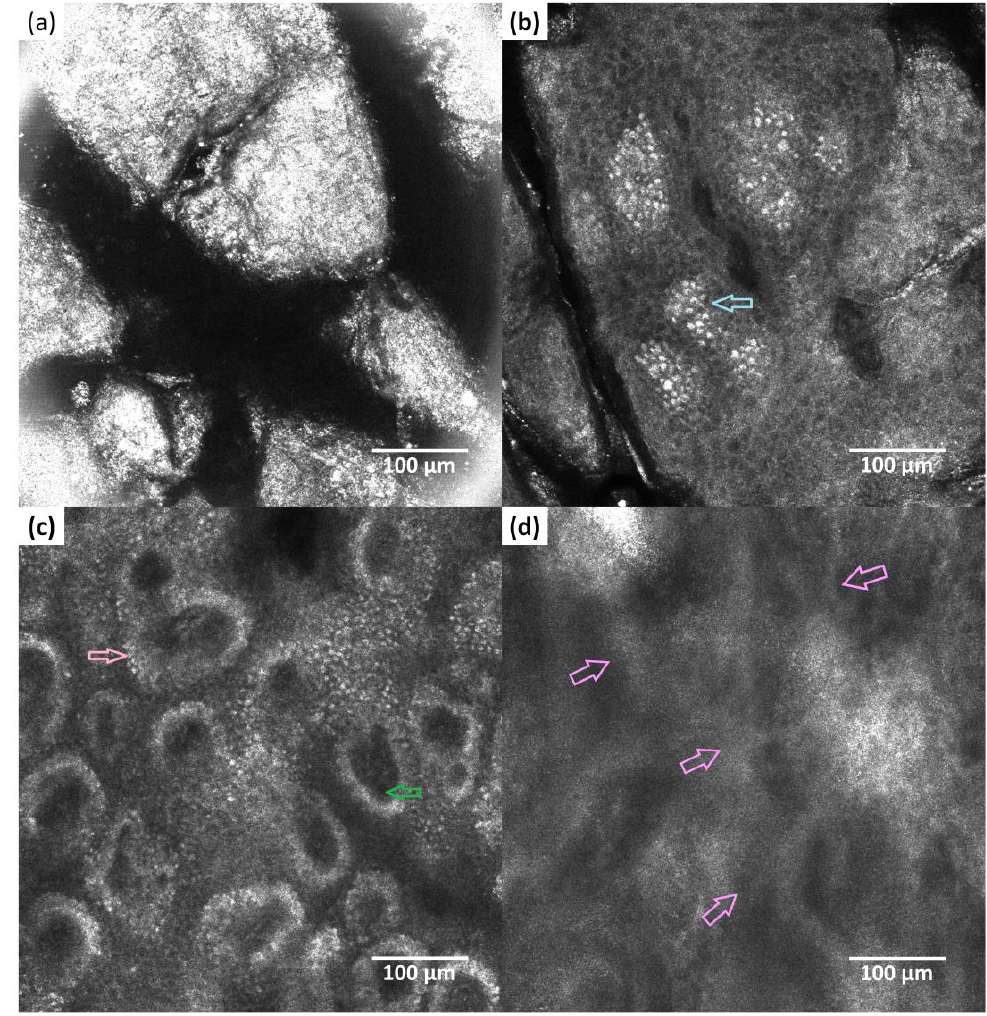
Figure 2. Reflectance confocal microscopy (RCM) images (500 × 500 µ m) of the normal skin—right forearm ( a ) cornified layer; ( b ) granular/spinous layer with regular honeycomb pattern; areas with cobblestone pattern (blue arrow) ( c ) dermal-epidermal junction—small basal cells and melanocytes arranged in a circular pattern (bright rings) (pink arrow) surrounding the dermal papillae (dark structures); small blood vessels inside the dermal papillae (green arrow); ( d ) dermis with elastic and collagen fibers visible as bright fibrillar or reticular structures (purple arrow).